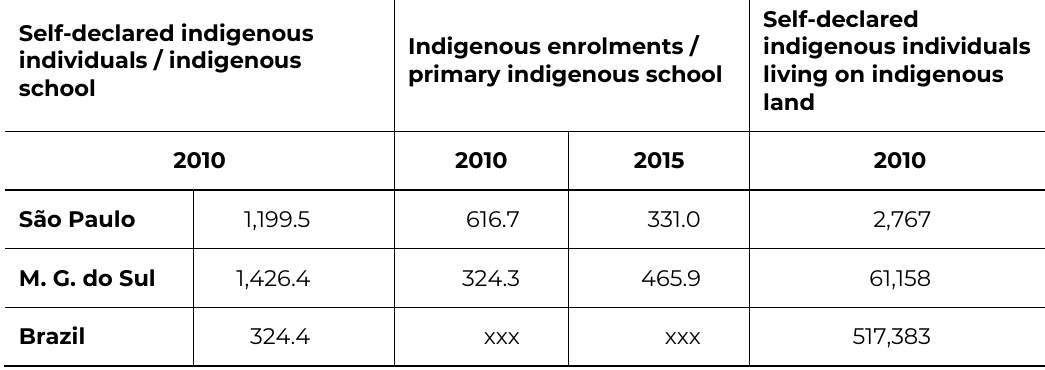
Table 4. Individuals living on indigenous land, indigenous people per school and school enrolment per indigenous school Self-declared indigenous